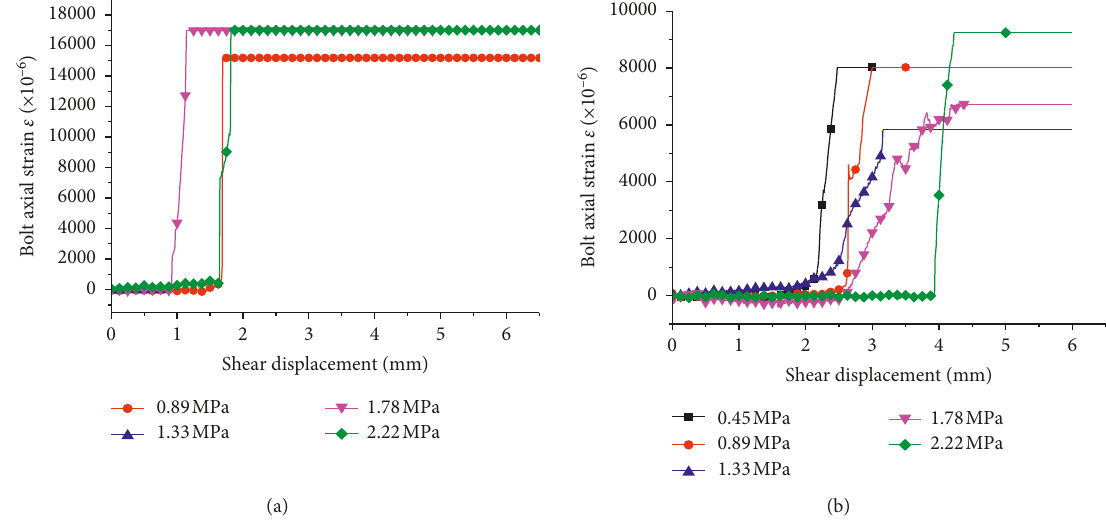
Figure 7: Strain-shear displacement curve of bolt in nonfilled joint with one bolt (a) and grouted joint with one bolt (b) of 45 °